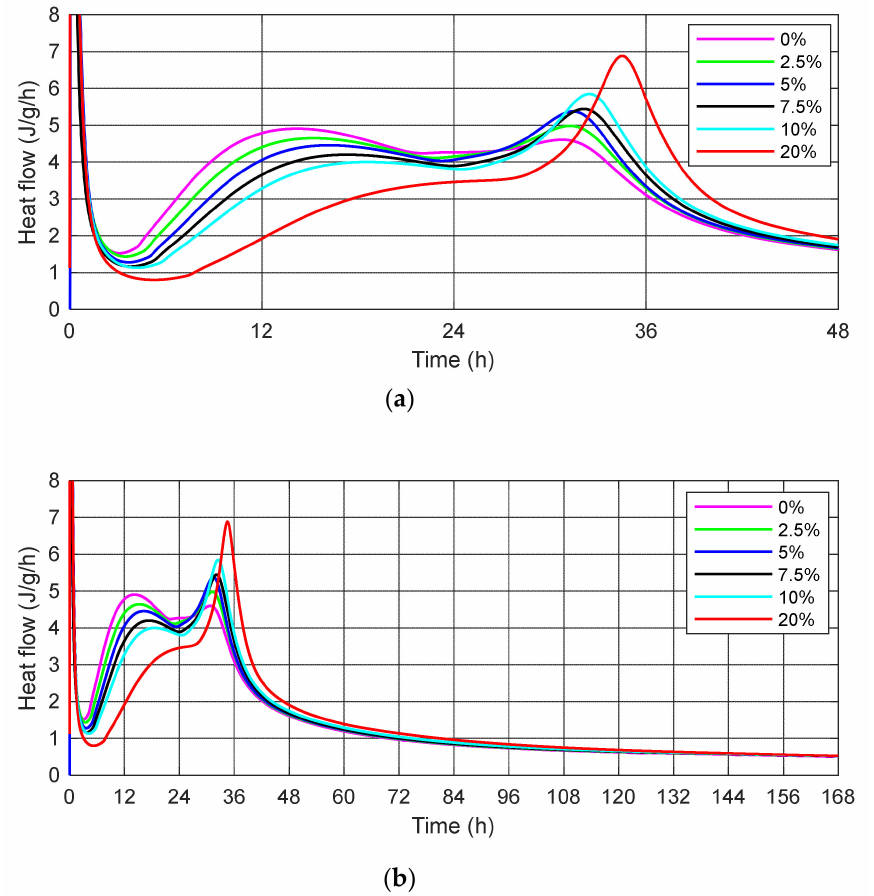
Figure 4. The rate of heat evolution of cement mortars (dQ/dt) without and with 2.5%, 5%, 7.5%, 10% and 20% sewage sludge ash (SSA) curing at 23 ◦ C during ( a ) first 48 h; ( b ) 168